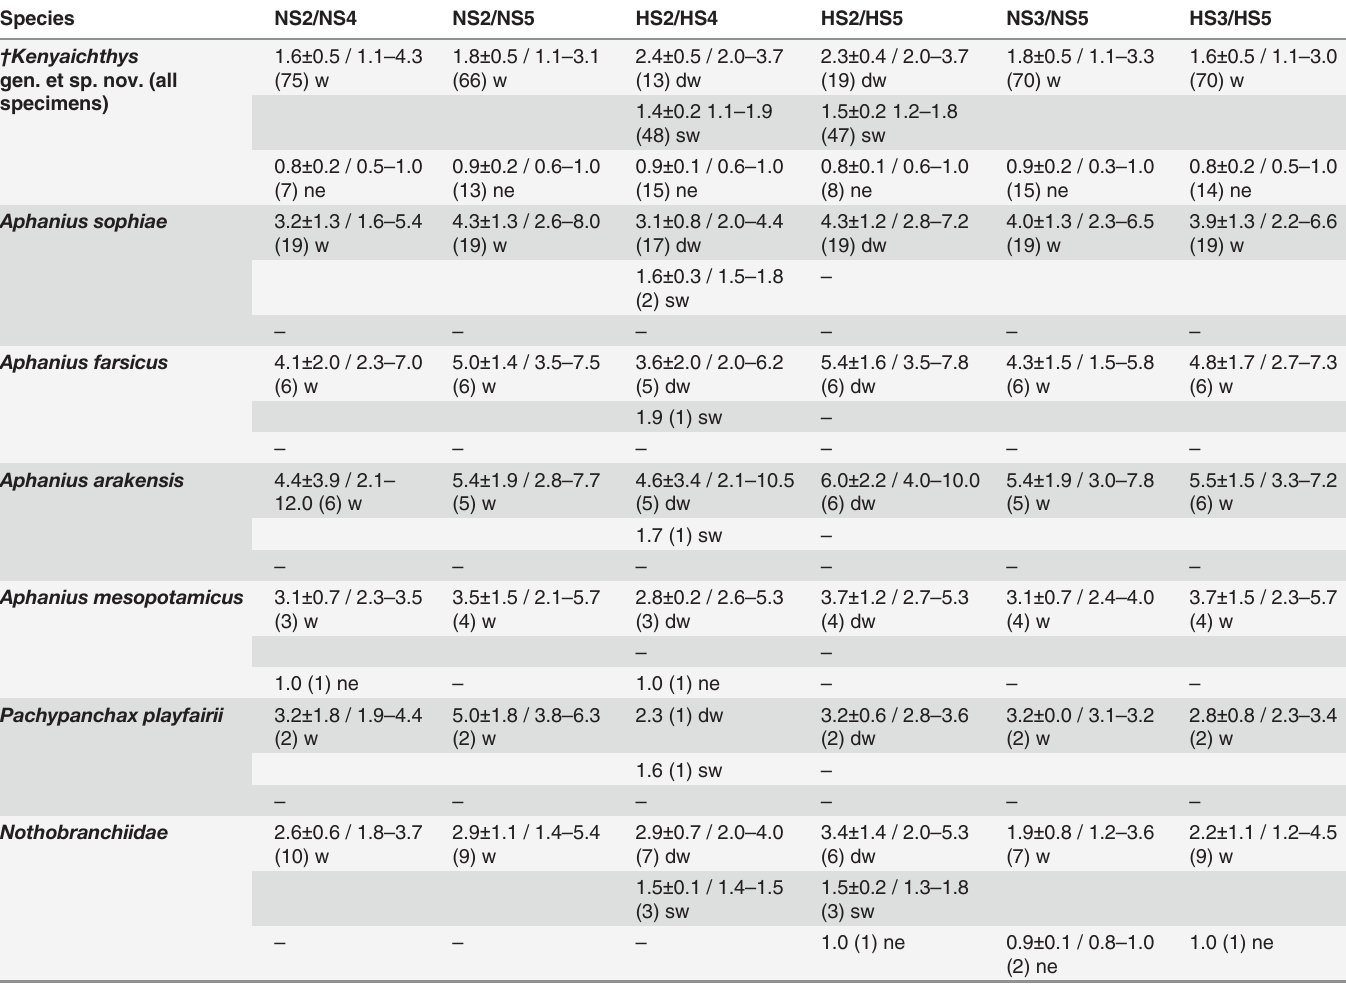
Table 3. Spine ratios (means and ranges) of † Kenyaichthys gen. et sp. nov. and the recent cyprinodontiform species used for comparison. Species NS2/NS4 NS2/NS5